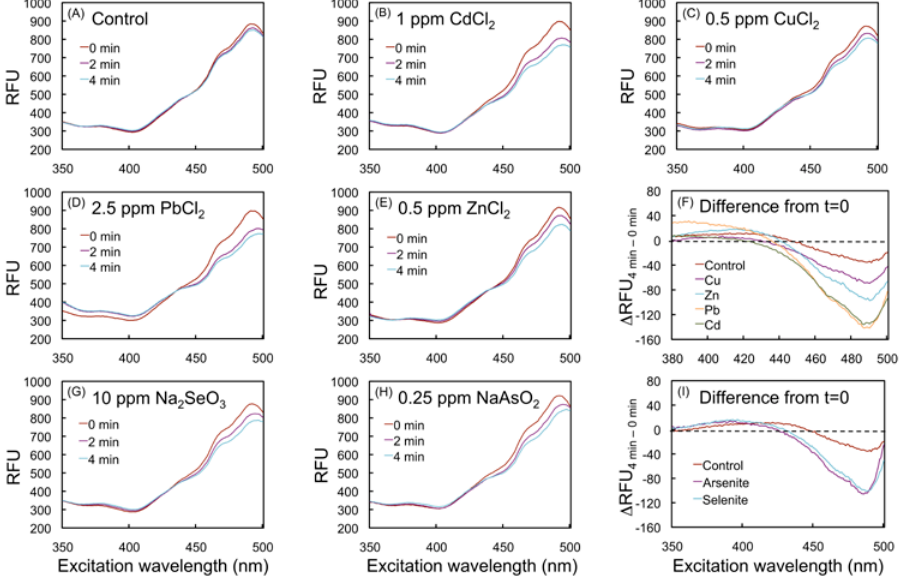
Figure 2. Spectroscopic analysis of E. coli -roGFP2 after induction of cellular oxidation by heavy metal compounds and oxyanions. Fluorescent excitation spectra of kinetic experiments after exposure of 4 minutes to water (A), 1 ppm CdCl (B), 0.5 ppm CuCl 2 2 (C), 2.5 ppm PbCl (D) and 0.5 ppm ZnCl (E). Overall comparison among control and 2 2 cations at 4 minutes after subtraction from 0 minute (E). Kinetic data obtained after 4 minutes exposure to 0.25 ppm NaAsO (F) and 10 ppm Na SeO (G). Overall 2 2 3 comparison among oxyanions at 4 minutes after subtraction from 0 minute (I).